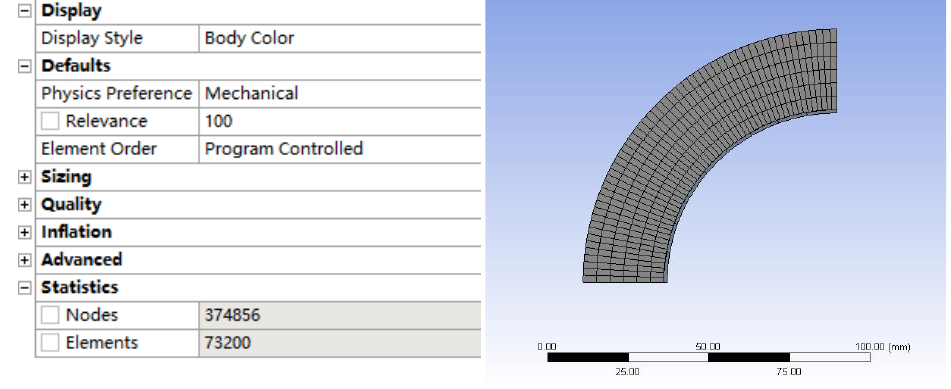
Figure 2. Diagram of cross-section grid.